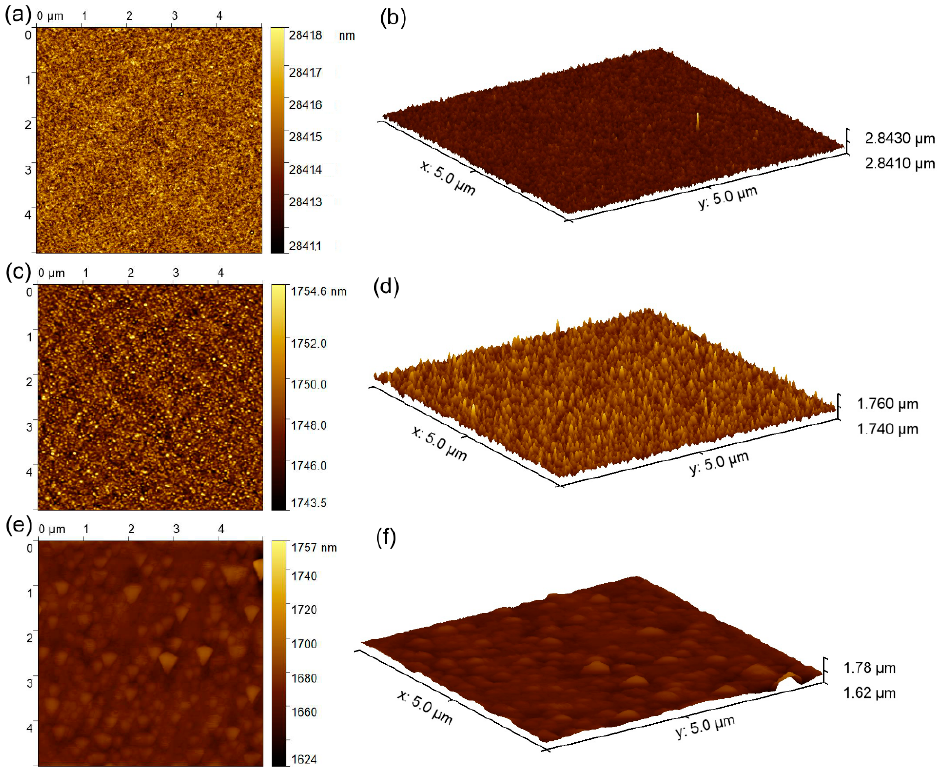
Figure 8. 2D AFM topography of CS–HAp coatings obtained at: p = 2 × 10 − 3 mbar ( a ); p = 5 × 10 − 3 mbar ( c ); p = 1.2 × 10 − 2 mbar ( e ). 3D representation of AFM topography obtained on CS–HAp coatings: p = 2 × 10 − 3 mbar ( b ); p = 5 × 10 − 3 mbar ( d ); p = 1.2 × 10 − 2 mbar ( f ).